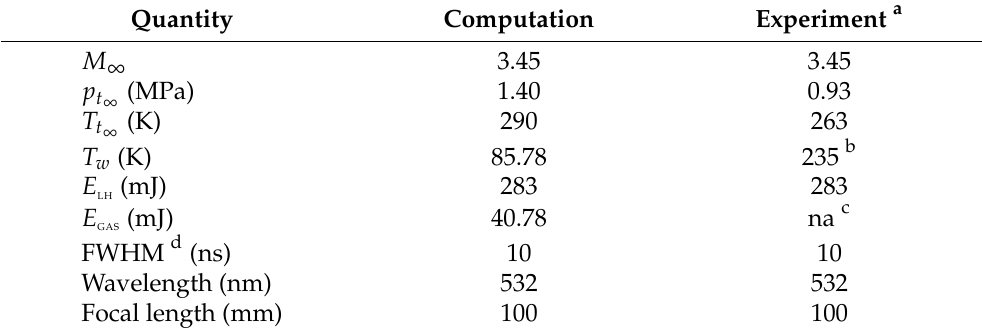
Table 10. Flow Conditions.